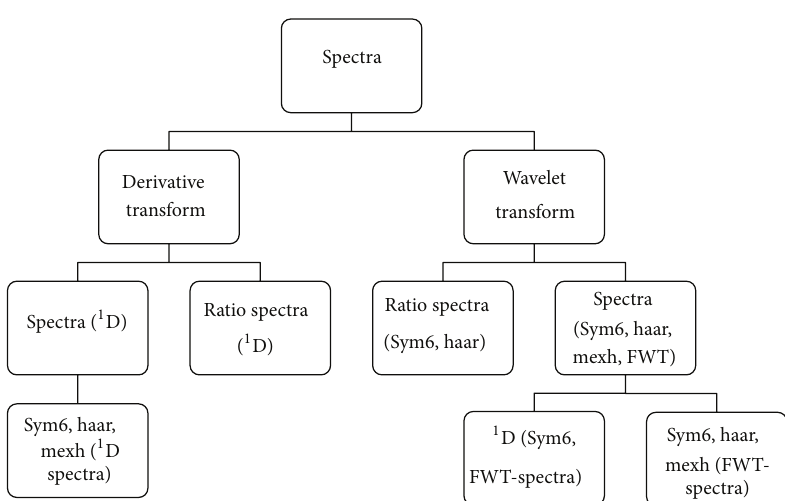
Figure 2: Derivative and wavelet transforms for the simultaneous determination of IB and PA in binary mixtures.